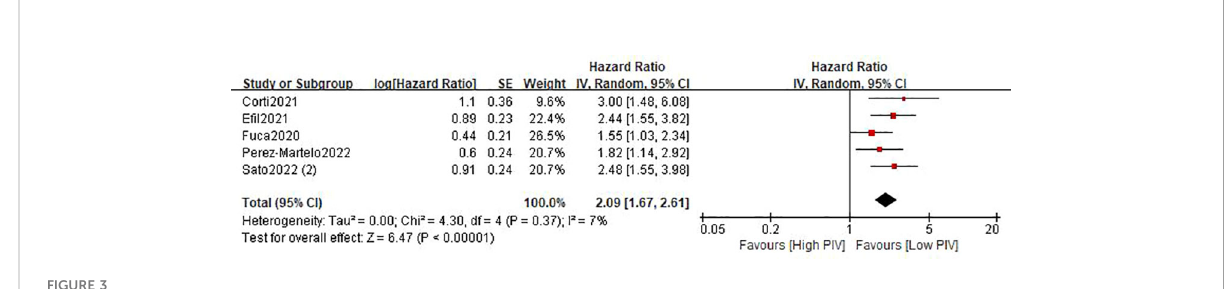
FIGURE 3 Forest plot assessing the relationship between PIV and